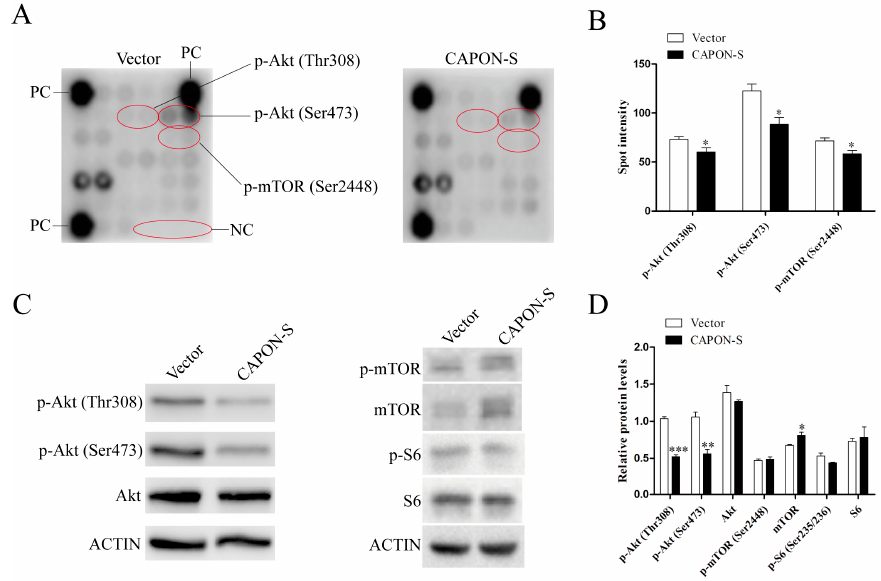
Figure 5. Regulation effect of overexpressing CAPON-S on the Akt and mTOR signaling. ( A , B ) Antibody array was used to screen important signaling molecules in Vector and CAPON-S U87 glioma cells. Representative spot pictures are shown in ( A ); PC, positive control; NC, negative control. The spot intensities of those molecules with significant changes, such as p-Akt (Thr308), p-Akt (Ser473), and p-mTOR (Ser2448), are shown in ( B ); ( C , D ) Western blot was used to confirm the antibody array data in Vector and CAPON-S U87 glioma cells; Representative blot pictures are shown in ( C ); Quantitative graphs for the relative protein levels normalized to Actin are shown in ( D ). (* p < 0.05; ** p < 0.01; *** p < 0.001).